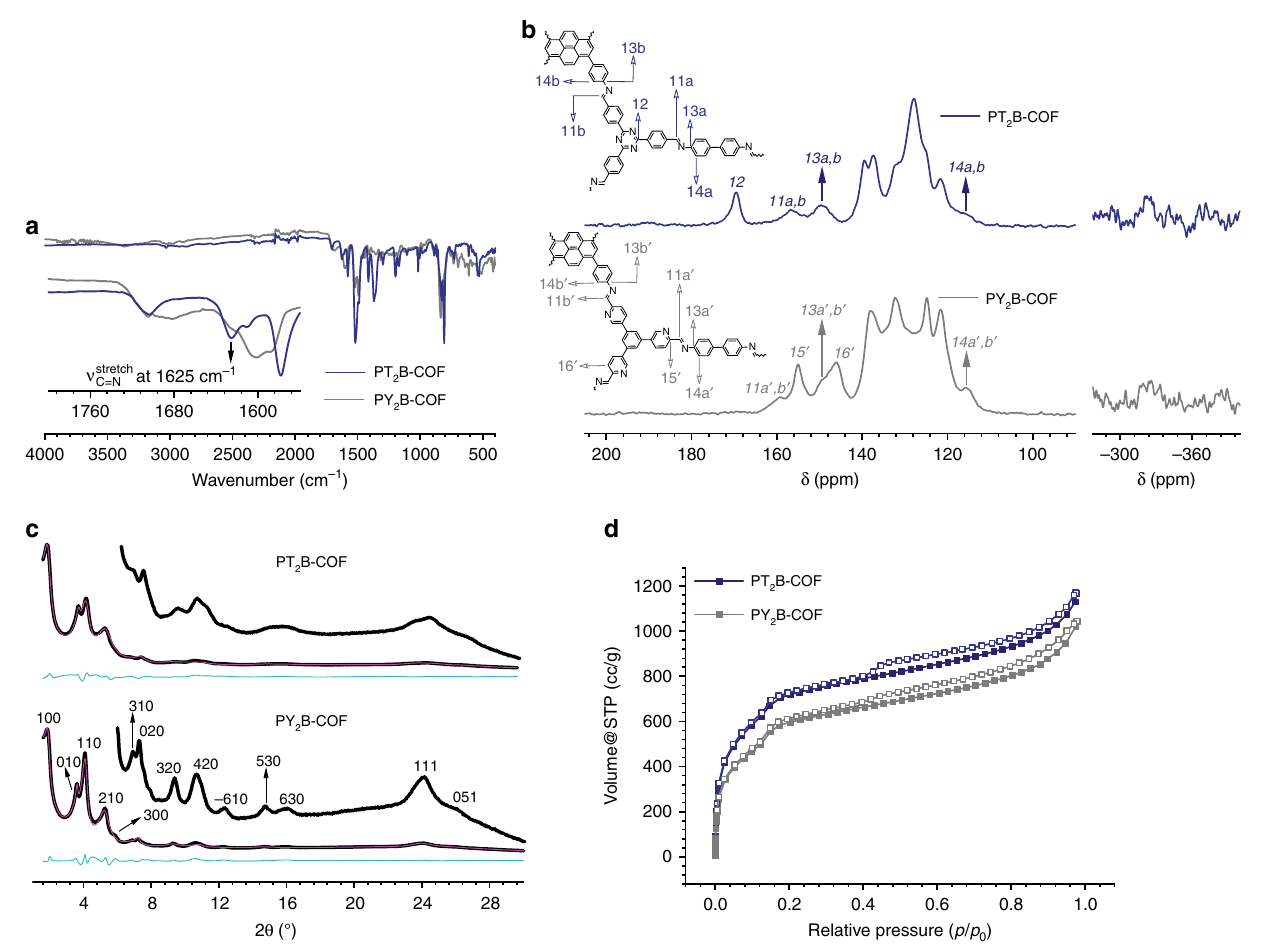
Fig. 5 Characterization of PT 2 B- and PY 2 B-COFs. a FT-IR characterization of PT 2 B- and PY 2 B-COFs. The inset shows the presence of ν C = N(stretch). b 13 C ssNMR spectra with corresponding assignments. The unassigned signals correspond to the pyrene moiety and the phenyl rings. 15 N ssNMR depicting the absence of free amine functionalities in PT 2 B- and PY 2 B-COFs is shown on the right as an inset. c PXRD patterns of PT 2 B- and PY 2 B-COFs with corresponding Rietveld re fi nements (magenta) showing good fi ts to the experimental data (black) with minimal differences. The turquiose traces show the difference between the experimental data and the re fi nement. The corresponding Miller indices of the identi fi able re fl ections are shown as well. d Argon sorption isotherms of PT 2 B- and PY 2 B-COFs at 87 K. Filled and open symbols represent the adsorption and the desorption branches,